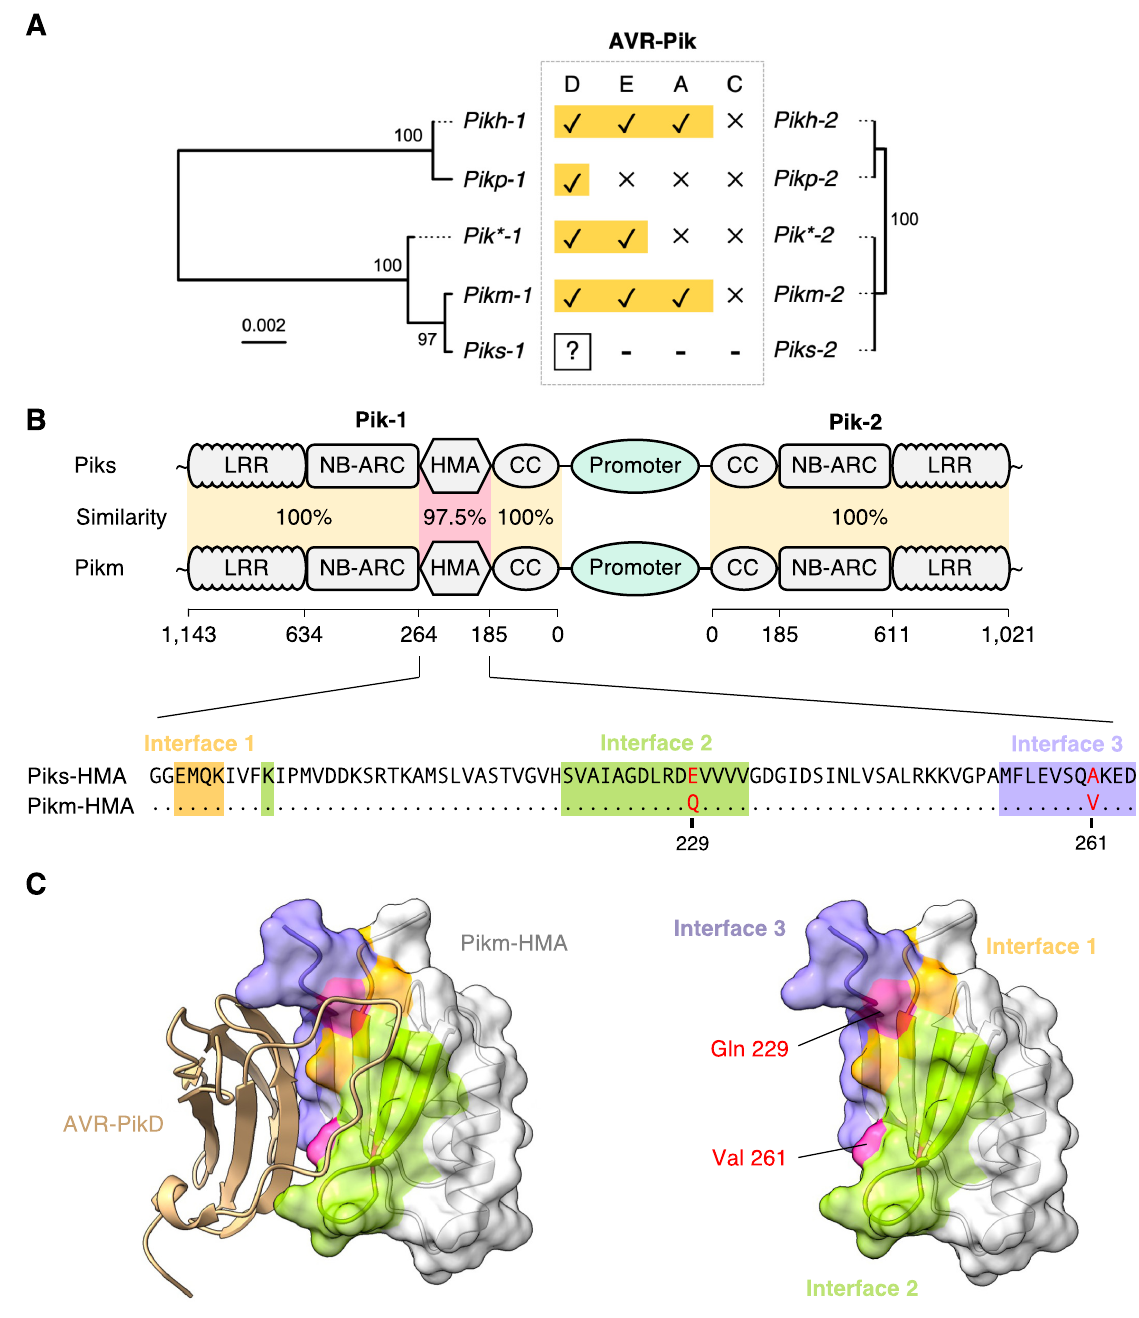
Fig 3. Two amino acid replacements differentiate Piks-1 from Pikm-1. (A) Phylogenetic trees of Pik resistance gene alleles are shown together with the experimentally validated protein interactions between Pik and AVR-Pik allelic products. The phylogenetic trees of Pik-1 and Pik-2 were drawn based on nucleotide sequences and show the closest genetic relationship between Piks and Pikm . ( B) Schematic representations of the gene locations and domain architectures of the NLR pair genes Pik-1 and Pik-2 . The genetically linked Pik-1 and Pik-2 share a common promoter region. Pik-1 has a non-canonical integrated HMA domain that binds M . oryzae AVR-Pik allelic products. Piks and Pikm differ by 2 amino acid replacements located at the integrated HMA domain of Pik-1. These polymorphisms, E229Q and A261V, are located at the binding interface 2 and 3 for AVR-PikD, respectively [71]. We calculated the sequence identities between Piks and Pikm based on amino acid sequences. (C) Structure of Pikm-HMA (PDB ID: 6FU9 chain A) in complex with AVR-PikD (PDB ID: 6FU9 chain B) [71]. The 2 amino acids differing between Piks-HMA and Pikm-HMA are exposed to the AVR-PikD-interaction site. The colors correspond to the colors of the alignment in (B). AVR, avirulence; NLR, nucleotide-binding domain and leucine-rich repeat protein receptor.